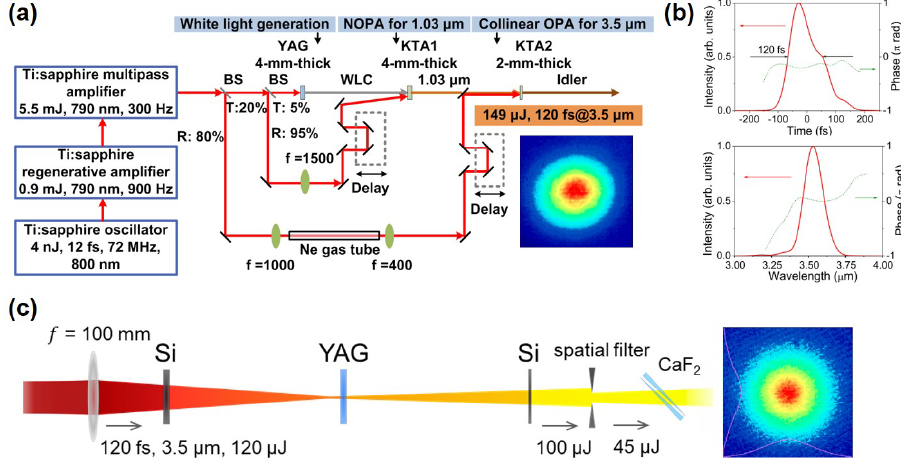
Fig. 1. (a): KTA-based, two-stage OPA pumped by a femtosecond chirp-pulse- amplification Ti:sapphire laser. BS, beam splitter; WLC, white light continuum; NOPA, noncolinear OPA. (b): Retrieved temporal profile and spectral shape of the MIR pulses characterized by SHG- FROG. (c): Multiple-plate pulse compressor after the MIR